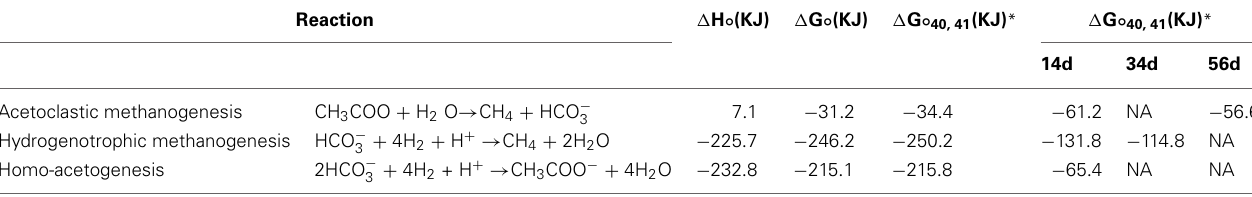
Table 6 | Gibbs free energies and enthalpies of possible microbial reactions in CO 2 injection experiment.